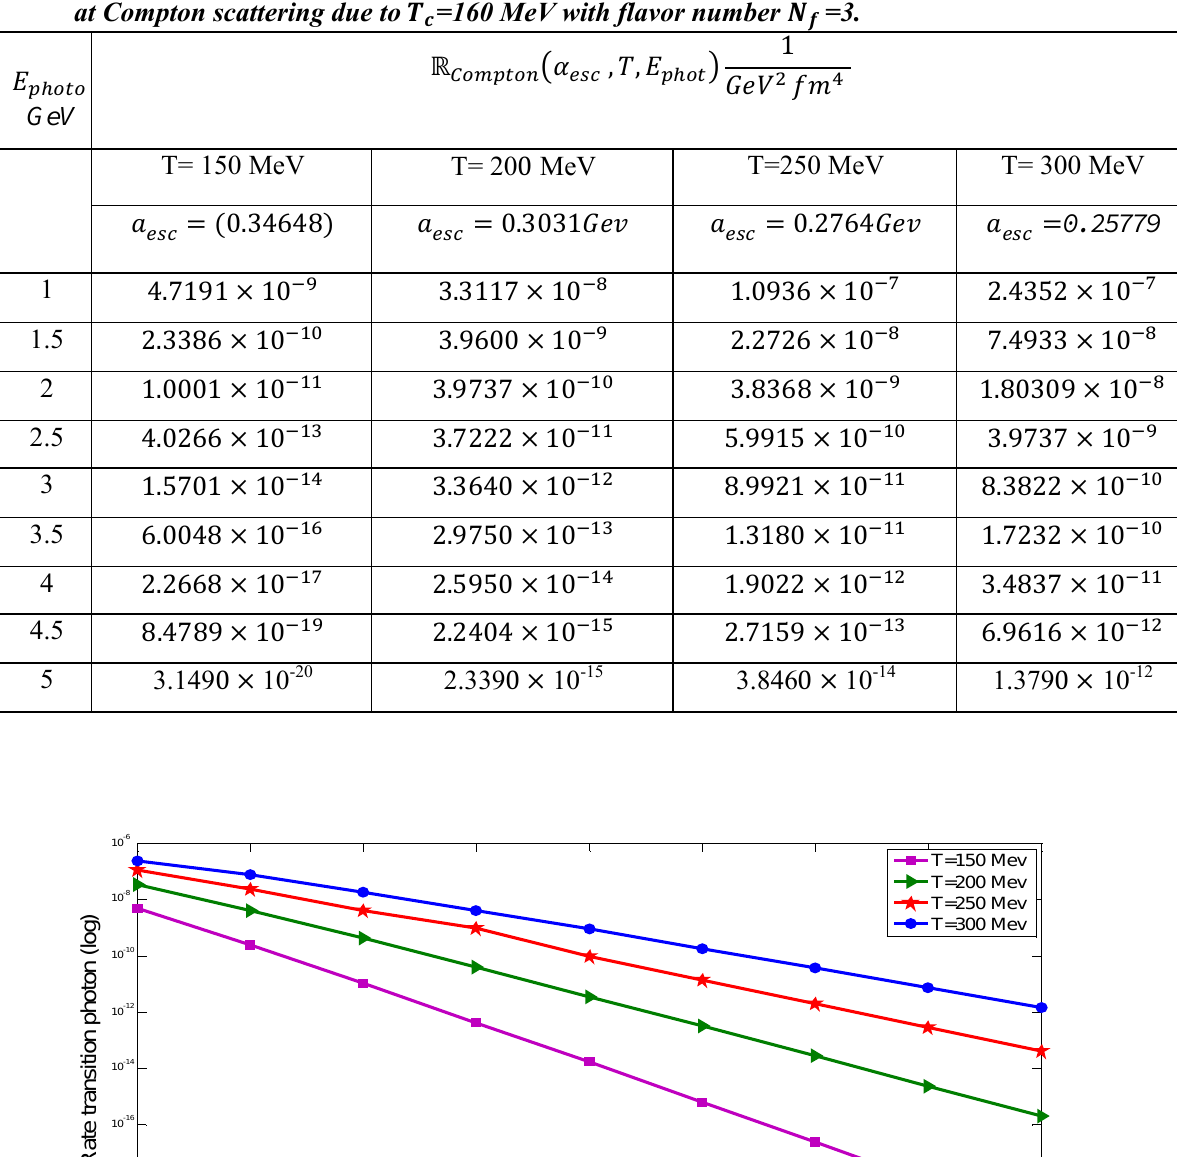
(cid:3435)(cid:2235) , (cid:2176), (cid:2161) (cid:3439) in ug → d (cid:2237) sytem (cid:2159)(cid:2197)(cid:2195)(cid:2198)(cid:2202)(cid:2197)(cid:2196) (cid:2187)(cid:2201)(cid:2185) (cid:2198)(cid:2190)(cid:2197)(cid:2202)(cid:2197) =160 MeV with flavor number (cid:2170) =3. (cid:2185) (cid:2188) 1 (cid:1337) (cid:3435)(cid:2009) , (cid:1846), (cid:1831) (cid:3439) (cid:3004)(cid:3042)(cid:3040)(cid:3043)(cid:3047)(cid:3042)(cid:3041) (cid:3032)(cid:3046)(cid:3030) (cid:3043)(cid:3035)(cid:3042)(cid:3047)